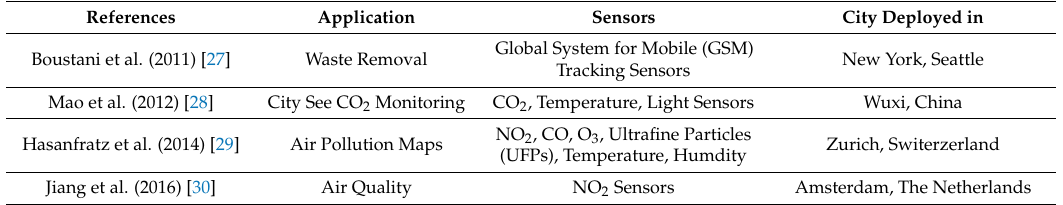
Table 1. Examples of prototyped applications for environmental monitoring. GSM: Global System for Mobile; UFPs: Ultrafine Particles.